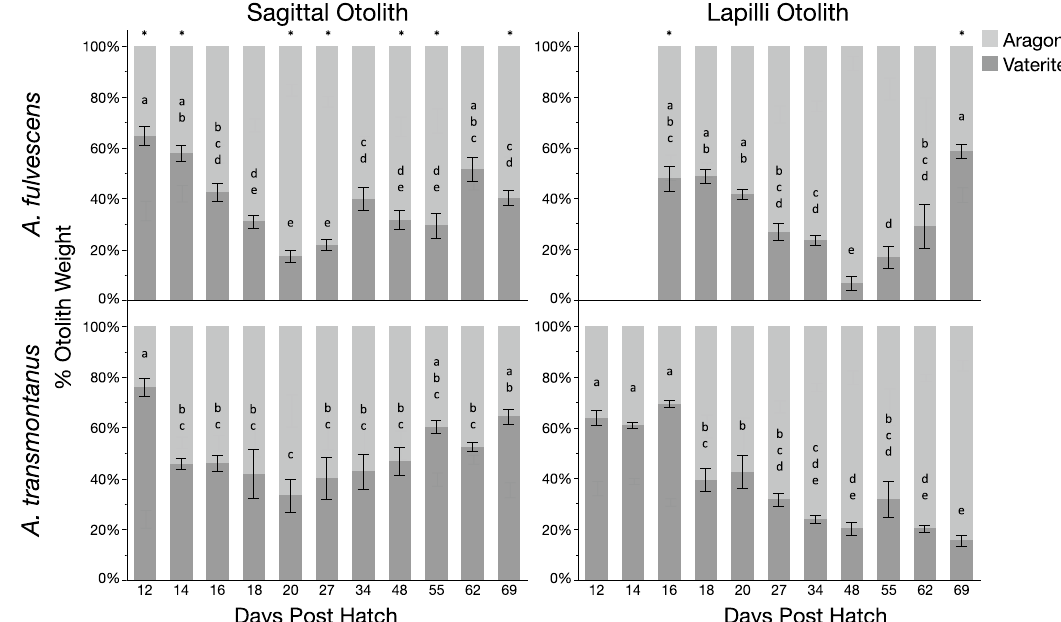
Figure 1. Mean (± s.e.m., n = 8 otoliths) percent polymorph composition (i.e., aragonite, vaterite) by weight of sagittal and lapilli otoliths collected throughout the ontogenetic development (i.e., days post hatch, dph) of Lake Sturgeon, Acipenser fulvescens, and White Sturgeon, A. transmontanus . Stars (*) indicate significant differences between species at developmental stage (i.e., days post hatch; dph) while letters indicate results of post-hoc Tukey HSD tests where developmental stages not sharing the same letter are significantly different. Lapilli otoliths of Lake Sturgeon are not included at 12 and 14 dph because they were too small to remove. Note the measured values are proportions thus the error bars apply to both aragonite and